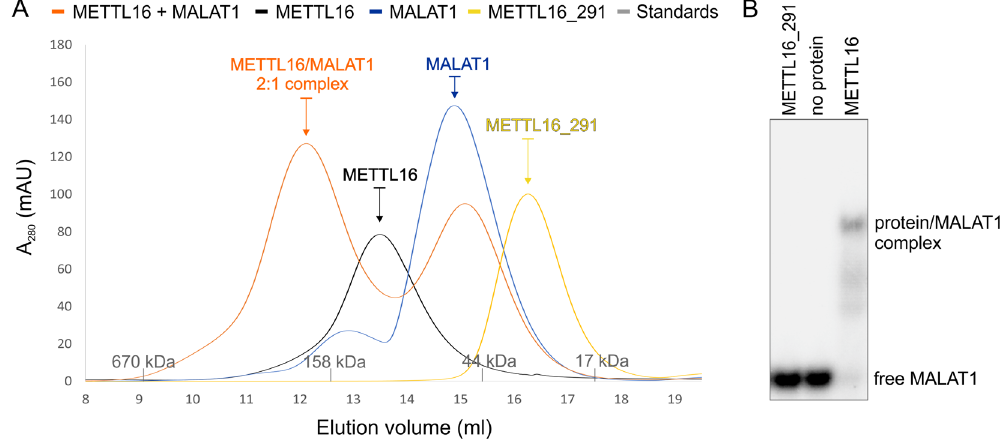
Figure 5. Analysis of METTL16-MALAT1 RNA triple helix interaction. ( A ) SEC revealed that METTL16 exists as a homodimer (SEC MW: ~103 kDa, black) while METTL16_291 is a monomer (SEC MW: ~31 kDa, yellow). SEC of the METTL16/MALAT1 RNA triple helix complex (SEC MW: ~188 kDa, orange) indicates a stoichiometry of 2:1 and also has a peak that elutes similar to the MALAT1 RNA triple helix (SEC MW: ~56 kDa, blue). Molecular weights of protein standards are shown as gray tick marks on x -axis. ( B ) Gel-shift assay showing that purified METTL16 (0.5 μ M dimer) interacts with 5 ′ -[ 32 P]-labeled MALAT1 RNA triple helix (2 nM), whereas METTL16_291 (1 μ M) does not. This gel image was cropped; the full-length gel image is shown in Fig.